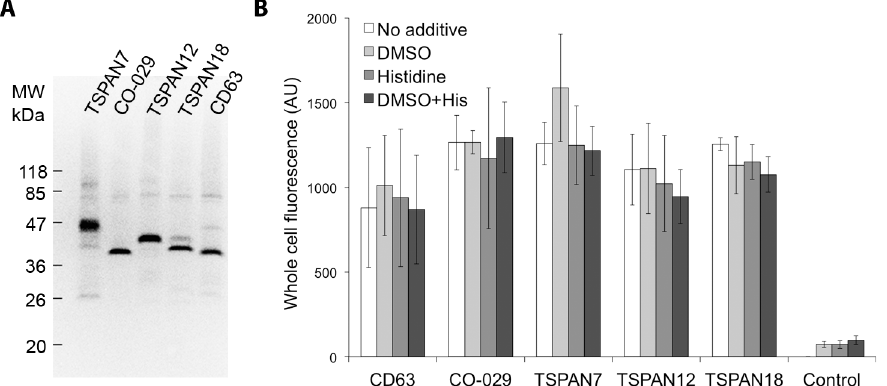
Fig 2. Recombinant expression of tetraspanins in S . cerevisiae . (A) SDS/PAGE in-gel fluorescence of crude membranes isolated from S . cerevisiae expressing GFP fusion of TSPAN7, CO-029, TSPAN12, TSPAN18 and CD63. (B) Quantification of whole cell fluorescence of TSPAN-GFP fusion proteins during induction supplemented with either 2.5% DMSO or 0.04% histidine, or both.